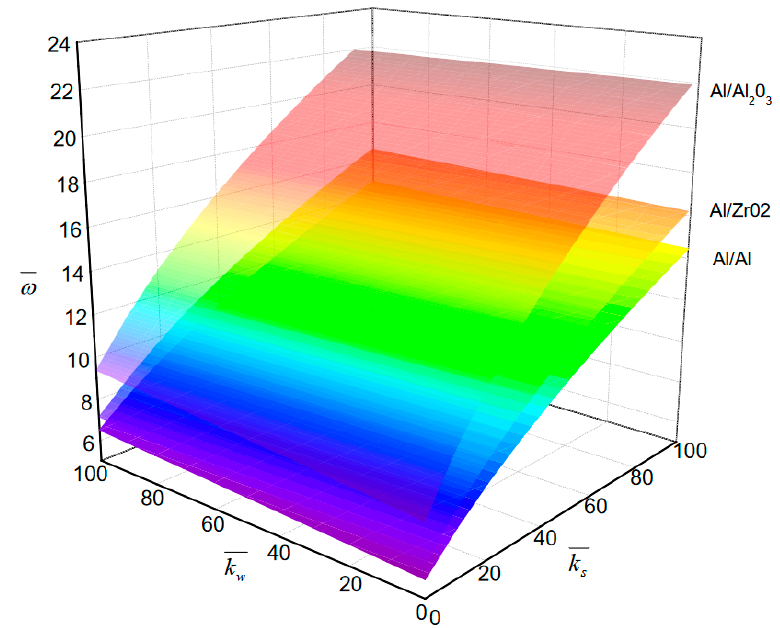
(cid:1)(cid:112) (cid:0)   2 / / a h E    ω a 2 / h ρ / E of different types of plates of different types of plates